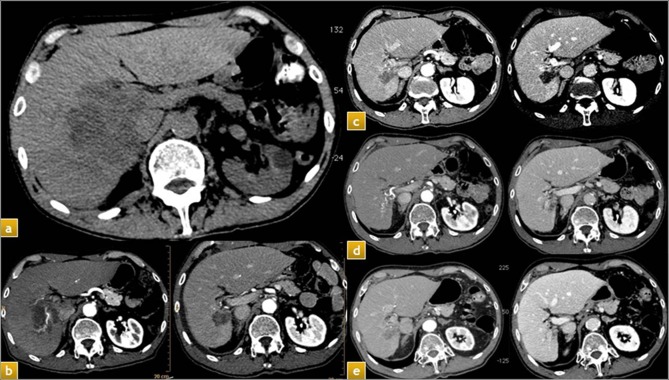
Patient with large HCC in the right lobe with main trunk portal thrombosis: a) baseline CT; b) CT assessment imaging one month after TARE; c) CT imaging six months after TARE; d) CT imaging 12 months after TARE; e) CT imaging 24 months after TARE.